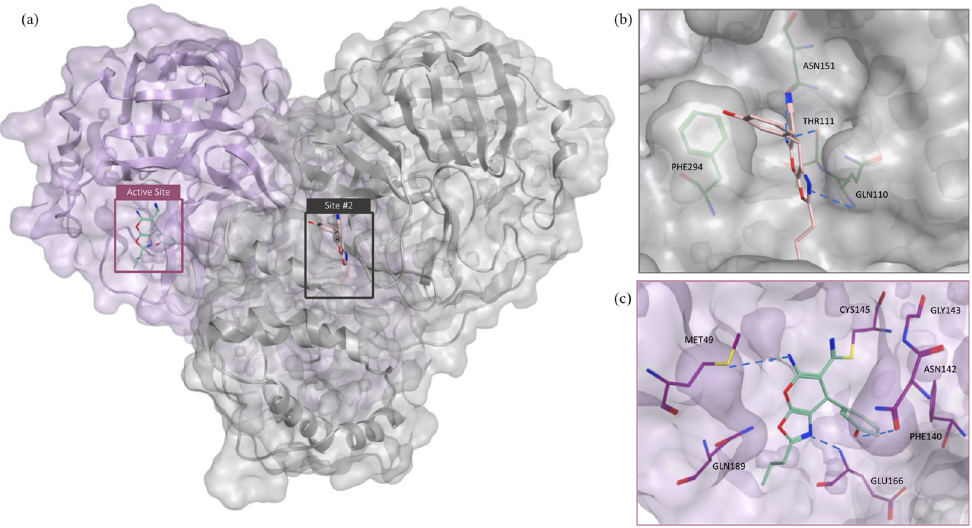
Figure 7. ( a ) Two potential binding sites for GR20, ( b ) GR20 docked in allosteric site #2, and ( c ) GR20 covalently docked in the catalytic site of M pro .